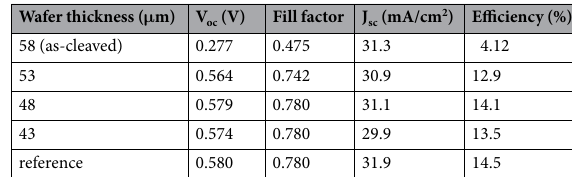
Table 1. Device performance parameters of the solar cells based on the kerfless wafers with etching implantation damages. The